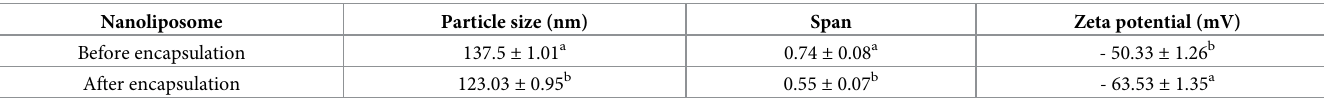
Table 3. The particle size and zeta potential of nanoliposomes before and after encapsulation. Nanoliposome Before encapsulation After encapsulation Note: a and b letters show a significant level at a P-value of �